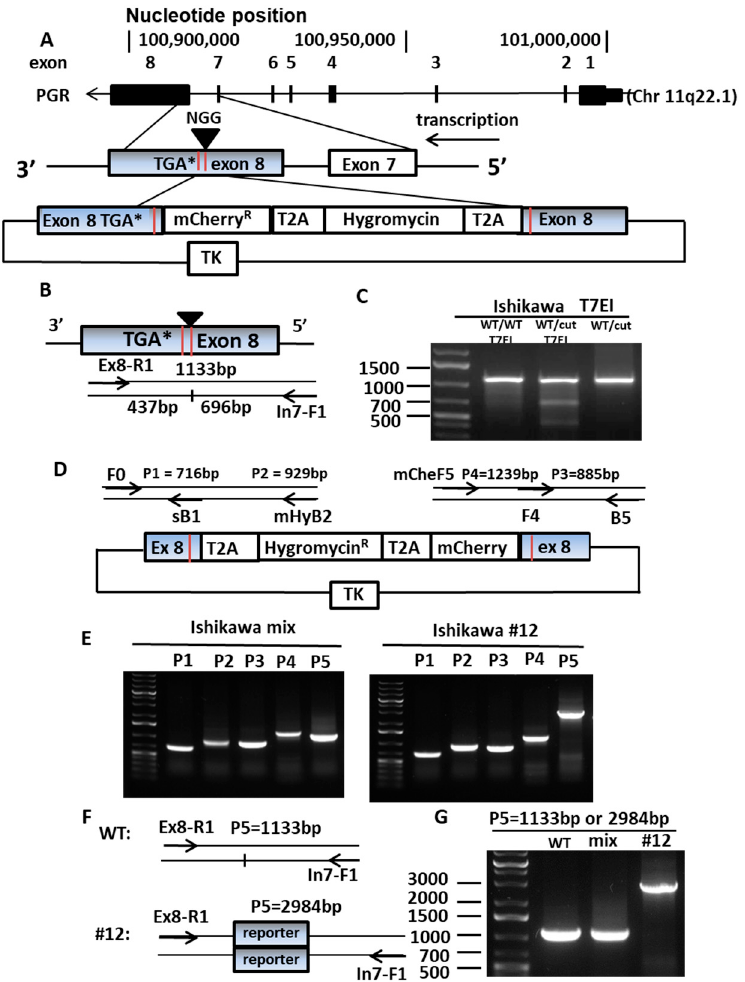
Figure 1. Establishing PR reporter gene expressing cells. ( A ) Construction of endogenous PR reporter gene. PGR gene map represents exon 1 to exon 8. An sgRNA was designed to target the 3 ′ end of exon 8 to generate a double strand break (DSB) close to TGA stop codon. A donor vector was created with four components: (1) a homologous recombination arm from intron 7 to the beginning of exon 8, (2) T2A and hygromycin, (3) T2A and mCherry, and (4) ending with the homologous recombination arm at exon 8. The donor vector was inserted into the PL253 vector, including the thymidine kinase (TK) gene, to help get rid of incorrectly inserted cells. ( B ) Diagram of PCR primers for Alt-R assay to validate the location of the DSB. The DSB will generate two DNA fragments with 437 bp and 696